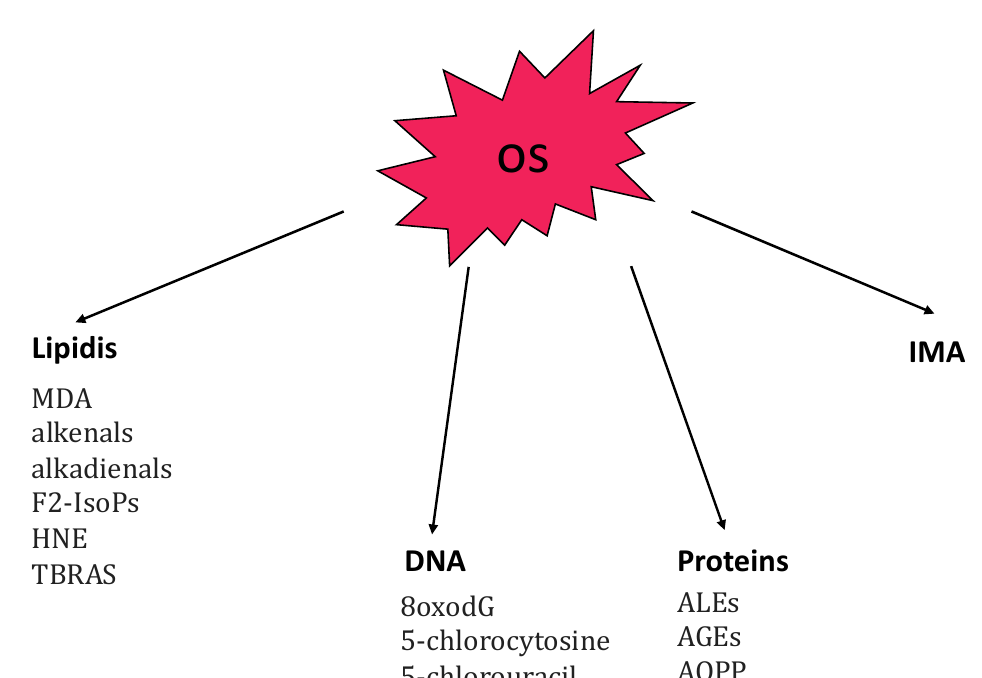
Figure 1. Summary of the main markers related to oxidative stress (OS) principal molecular targets: lipidis, DNA, proteins, and IMA. Abbreviations: 8oxodG, 7,8-dihydroxy-8-oxo-2 (cid:48) -deoxyguanosine; AGEs, advanced glycation end-products; ALEs, advanced lipoxigenation end-products; AOPP advanced oxidation protein-products; F2-IsoPs, F2-isoprostanes; HNE, 4-hydroxy-2-nonenal; IMA, ischemia-modified albumin; MDA, malondialdehyde; TBARS, thiobarbituric acid reactive substances